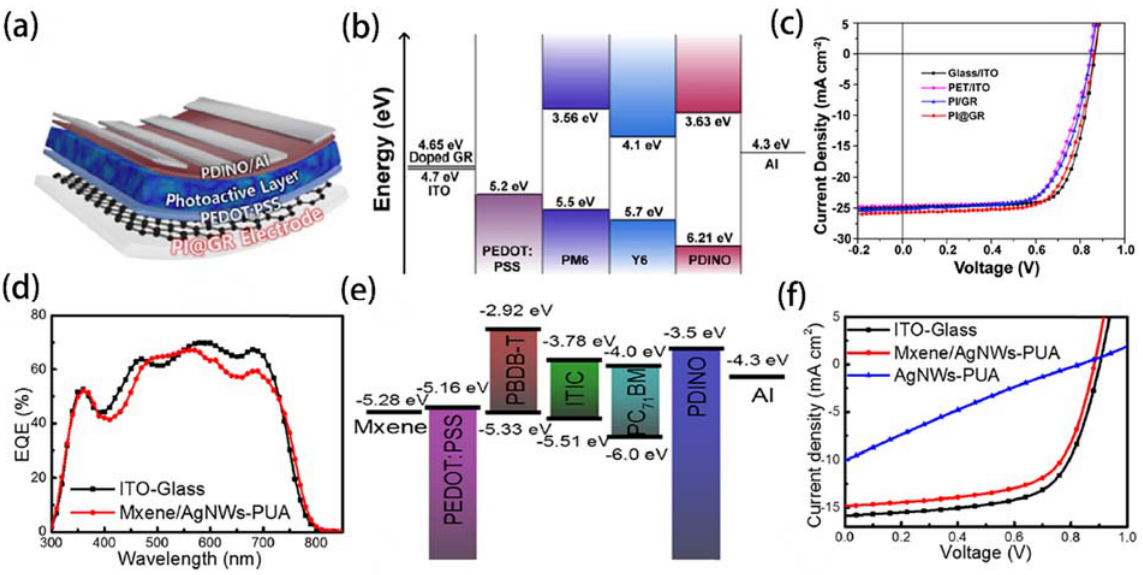
Figure 12. ( a ) Schematic of the device structure with PI@GR electrode; ( b ) The corresponding energy level diagram of the device; ( c ) J-V characteristics of PI@GR OSCs compared with OSCs with ITO; ( d ) EQE of OSCs based on PBDBT:ITIC:PC 71 BM with MXene/AgNW hybrid electrode; ( e ) Energy-level diagrams of OSCs based on PBDBT:ITIC:PC 71 BM; ( f ) J-V curves of the OSCs with MXene/AgNW hybrid electrode. Reprinted with permission form [104,105]. Copyright 2019 American Chemical Society and 2020 Elsevier Ltd.